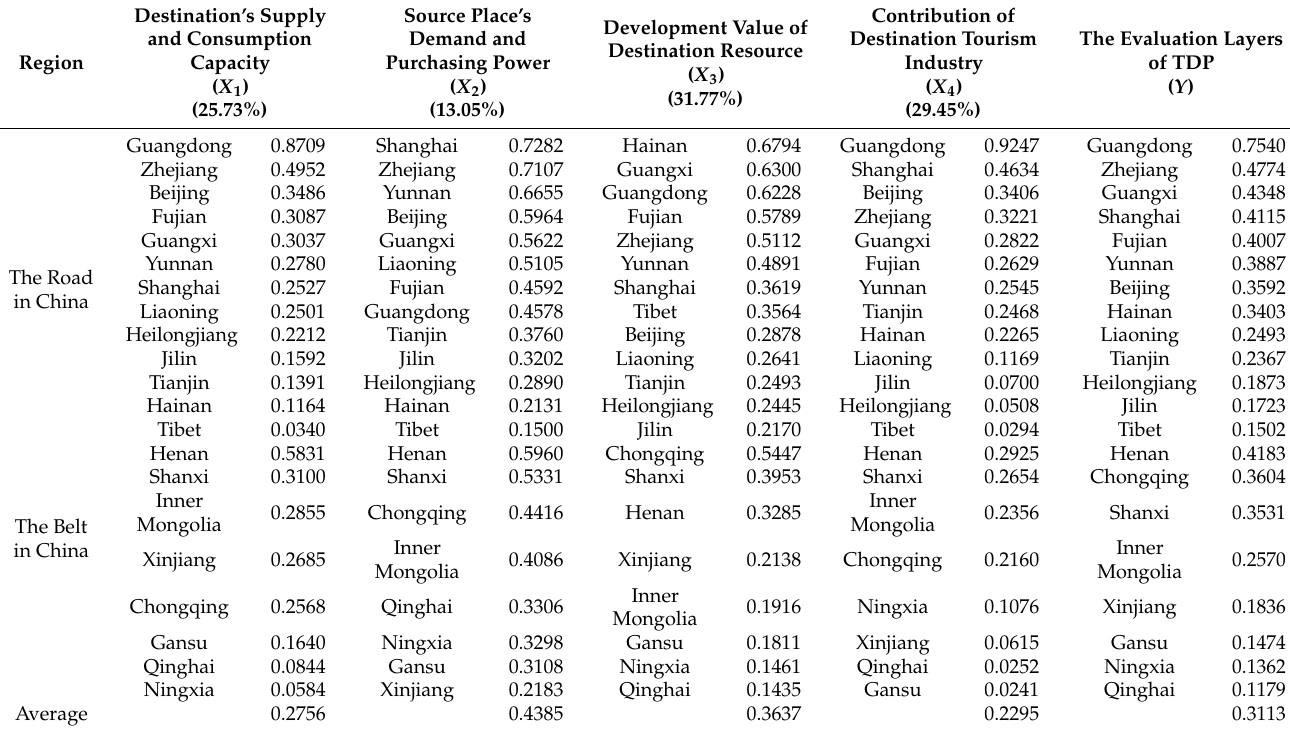
Table 4. TDP score of provincial units along the Belt and Road in